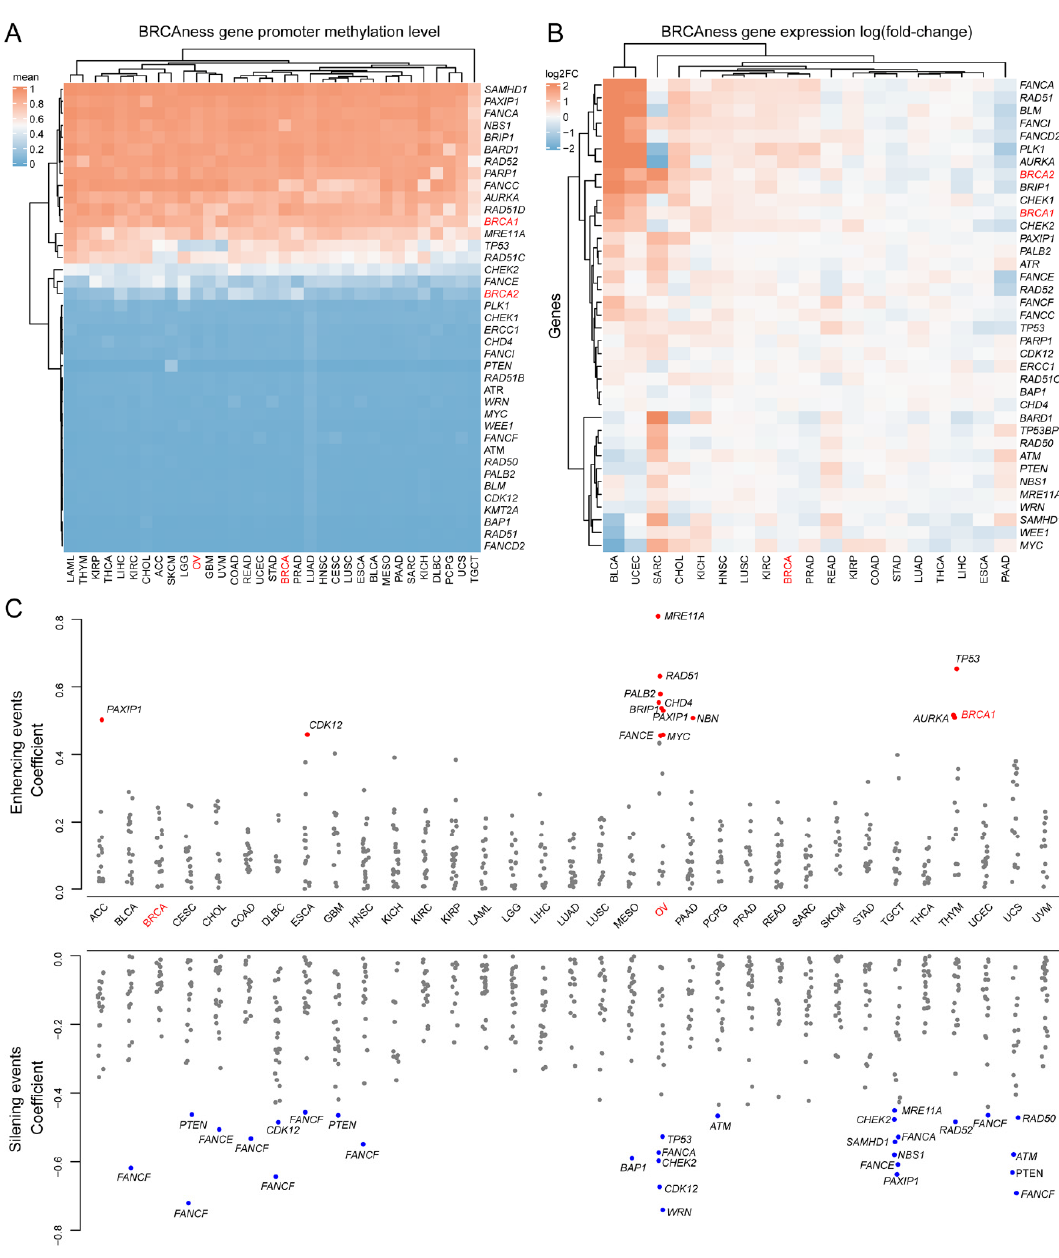
Figure 5. Methylation and transcriptional regulation of BRCAness genes. ( A ) Promoter methylation of BRCAness genes across 33 cancer types. It showed the mean beta value of all promoter